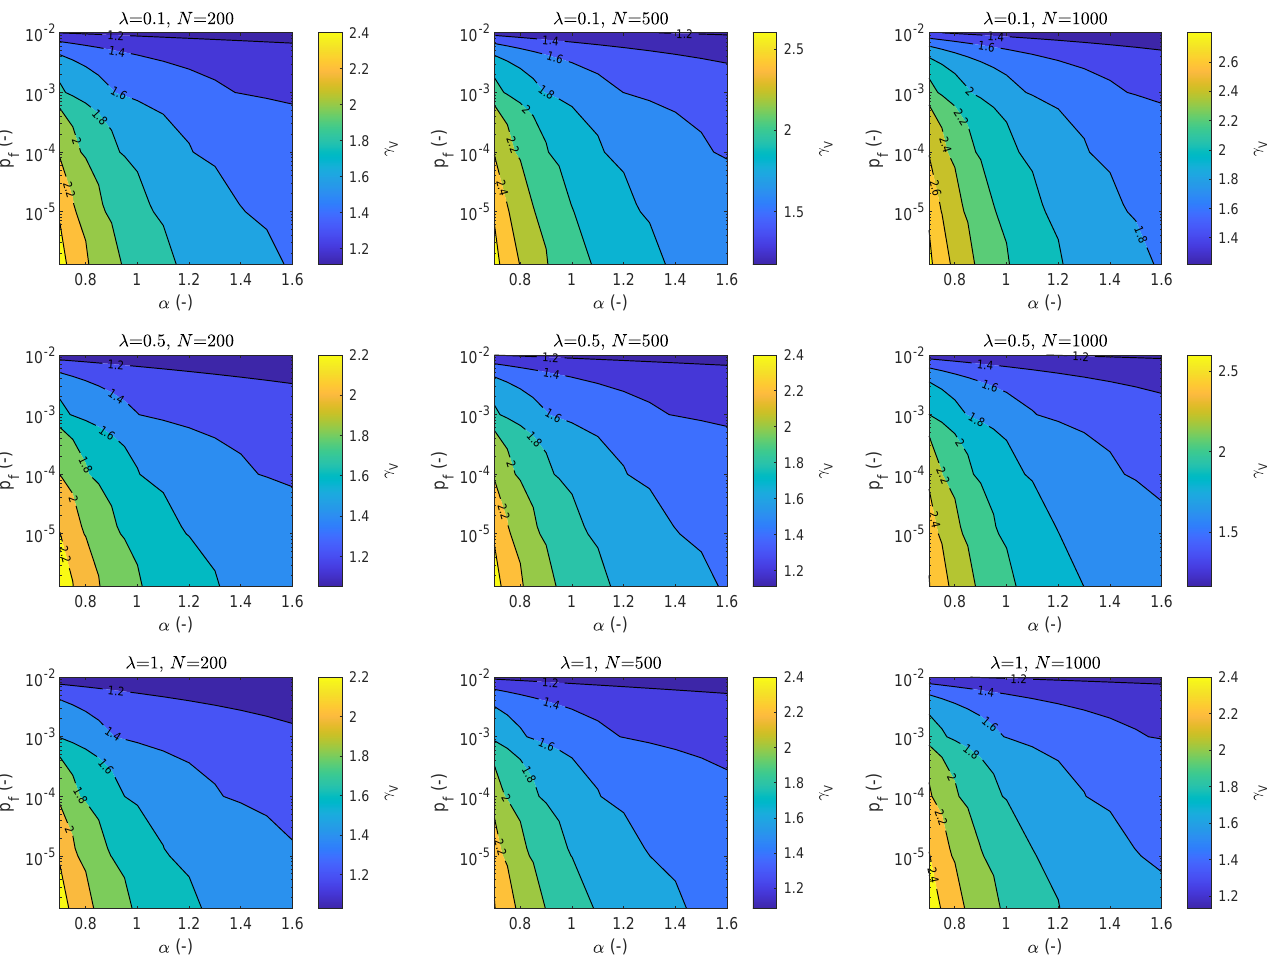
Figure A3. Partial safety factor related to the velocity, γ v , for variable failure probabilities considering a reference block mass having a return period T k = 50